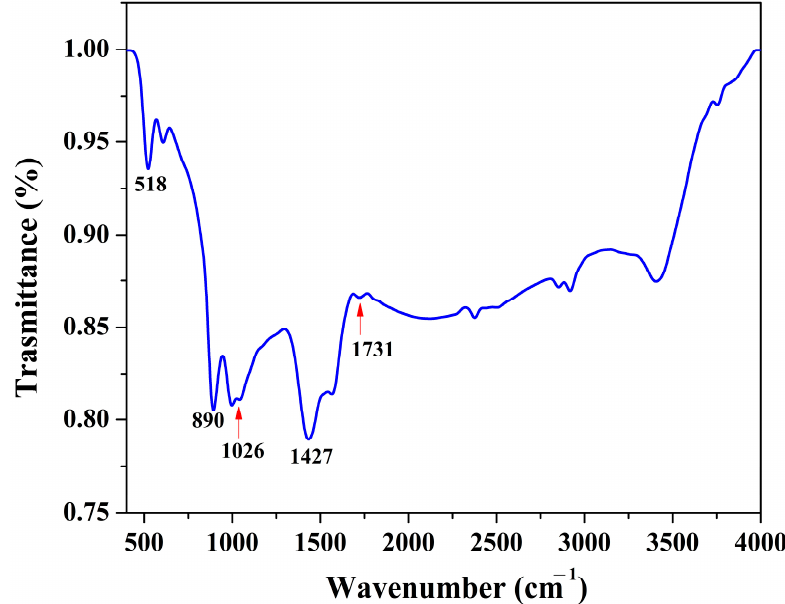
Figure 7. FTIR spectrum for a powder produced from hydrothermal treatment using 1.0 M KOH at 170 °C for 3 h and calcined at 600 °C.